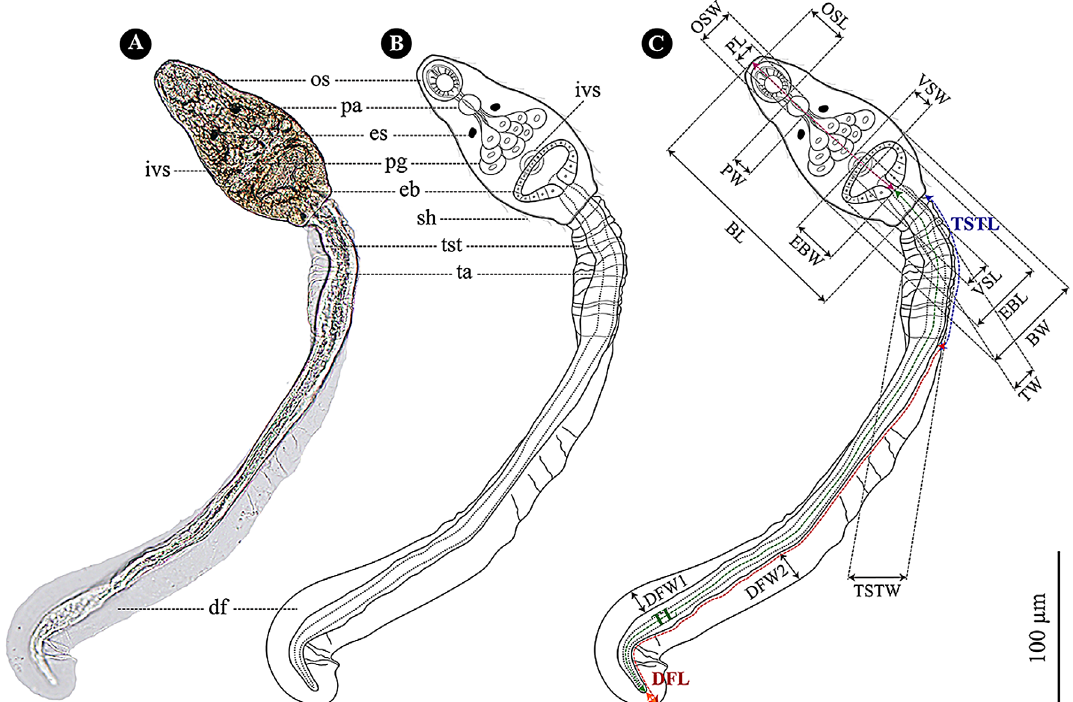
Figure 4. Morphology of Opisthorchis viverrini s.l. cercariae. (A) Photomicrograph of unstained cercaria fi xed in 10% NBF, (B) drawing image, (C) measured morphological characters. Abbreviations in (A) and (B): os = oral sucker, pa = pharynx, es = eye spot, pg = penetration gland, ivs = inconspicuous ventral sucker, eb = excretory bladder, sh = sensory hair, tst = transversely striated tegument, ta = tail, df = dorso- ventral fi nfold. The de fi nition of abbreviations in (C) was showed in the fi rst column of Table 4. Total length = length of purple dashed arrow + TL + length of orange arrow (at the position following the end of the